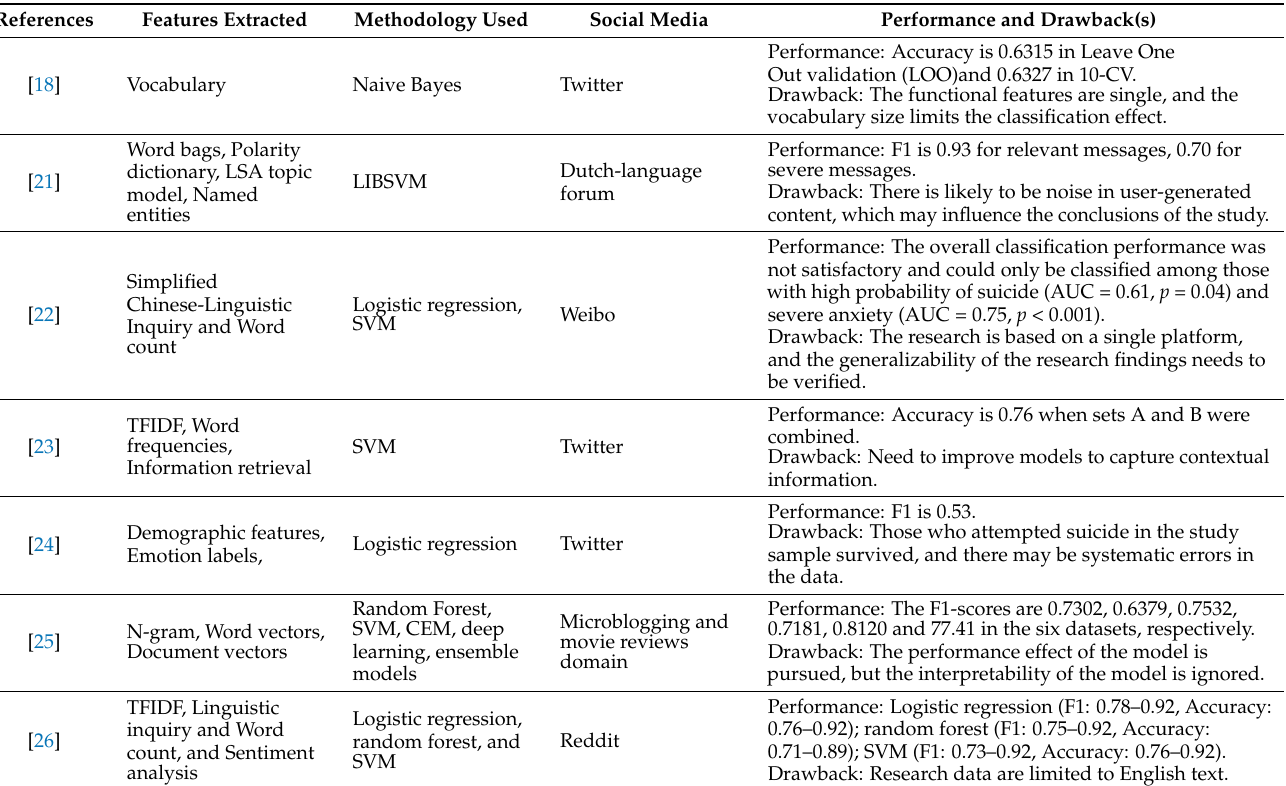
Table 1. A critical review of different suicide ideation detection studies on social